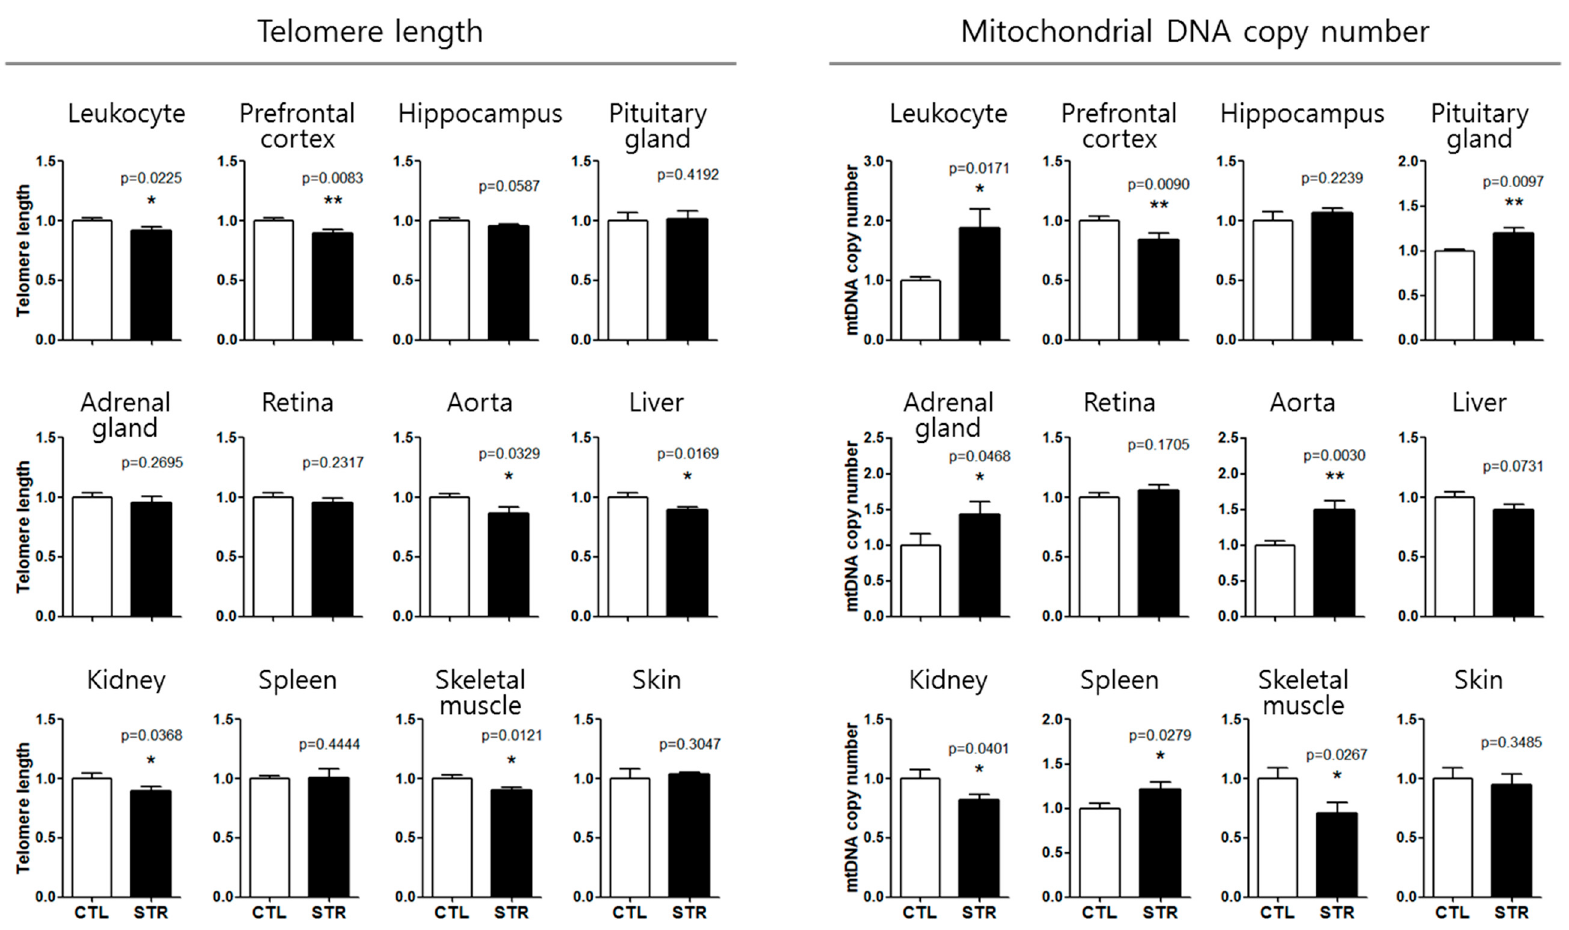
Figure 3. Chronic immobilization stress (CIS)-induced changes in telomere length and mitochondrial DNA copy number in 12 tissues. *, p < 0.05; **, p < 0.01 from unpaired Student’s t -test between control (CTL, n = 15) and stressed group (STR, n = 18).